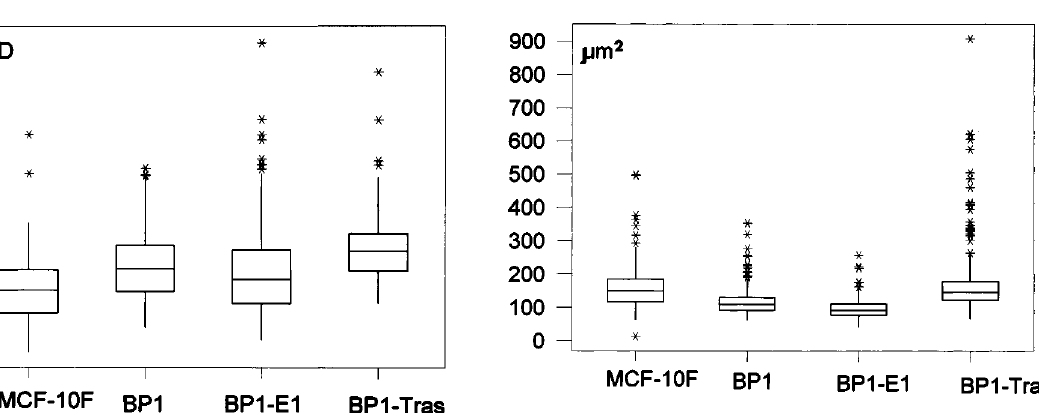
Fig. 3. Tukey’s box-and-whisker plots for OD values of MCF-10F cell lines. Lower and upper traces = lower and upper quartiles of the distributions; middle trace = median; (cid:3) = outliers. The plot for BP1-E1 cells was based on OD values obtained previously [17].